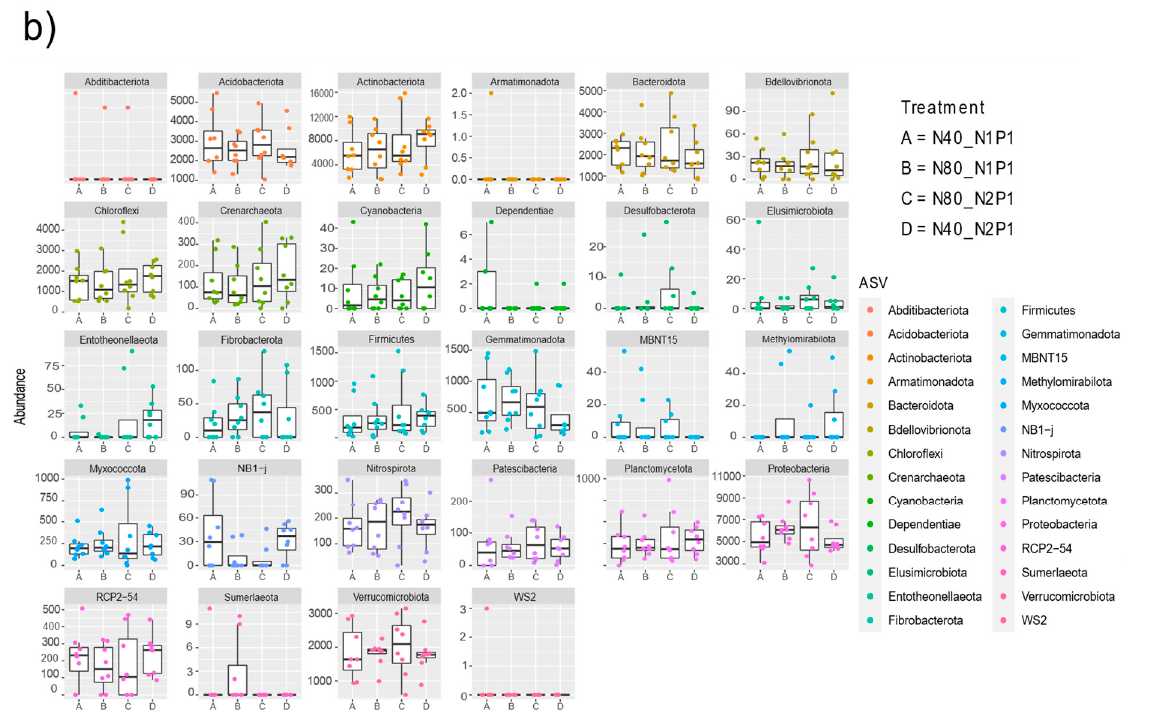
Figure 5. Variety and fertilization affect specific bacterial phyla abundances. Differential abundances of bacterial phyla in relation to wheat varieties and fertilization is reported from DeSeq2 analysis result. For each phylum, the abundance is reported on the y axis with respect to the varieties ( a ) and the fertilization ( b